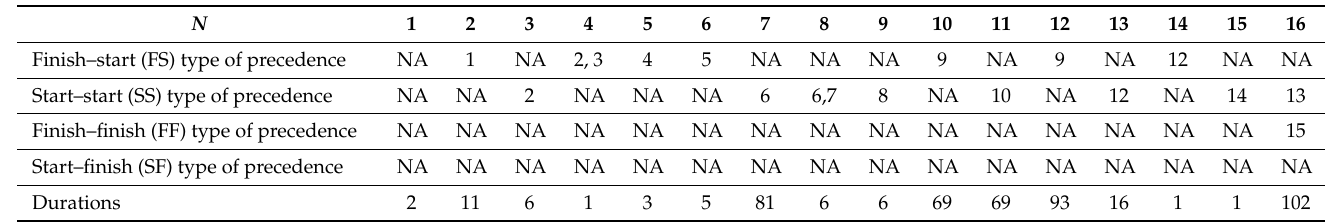
Table 3. Case of “Parkowo-Le´sne” estate complex project: Types of precedence between individual stages of the project.